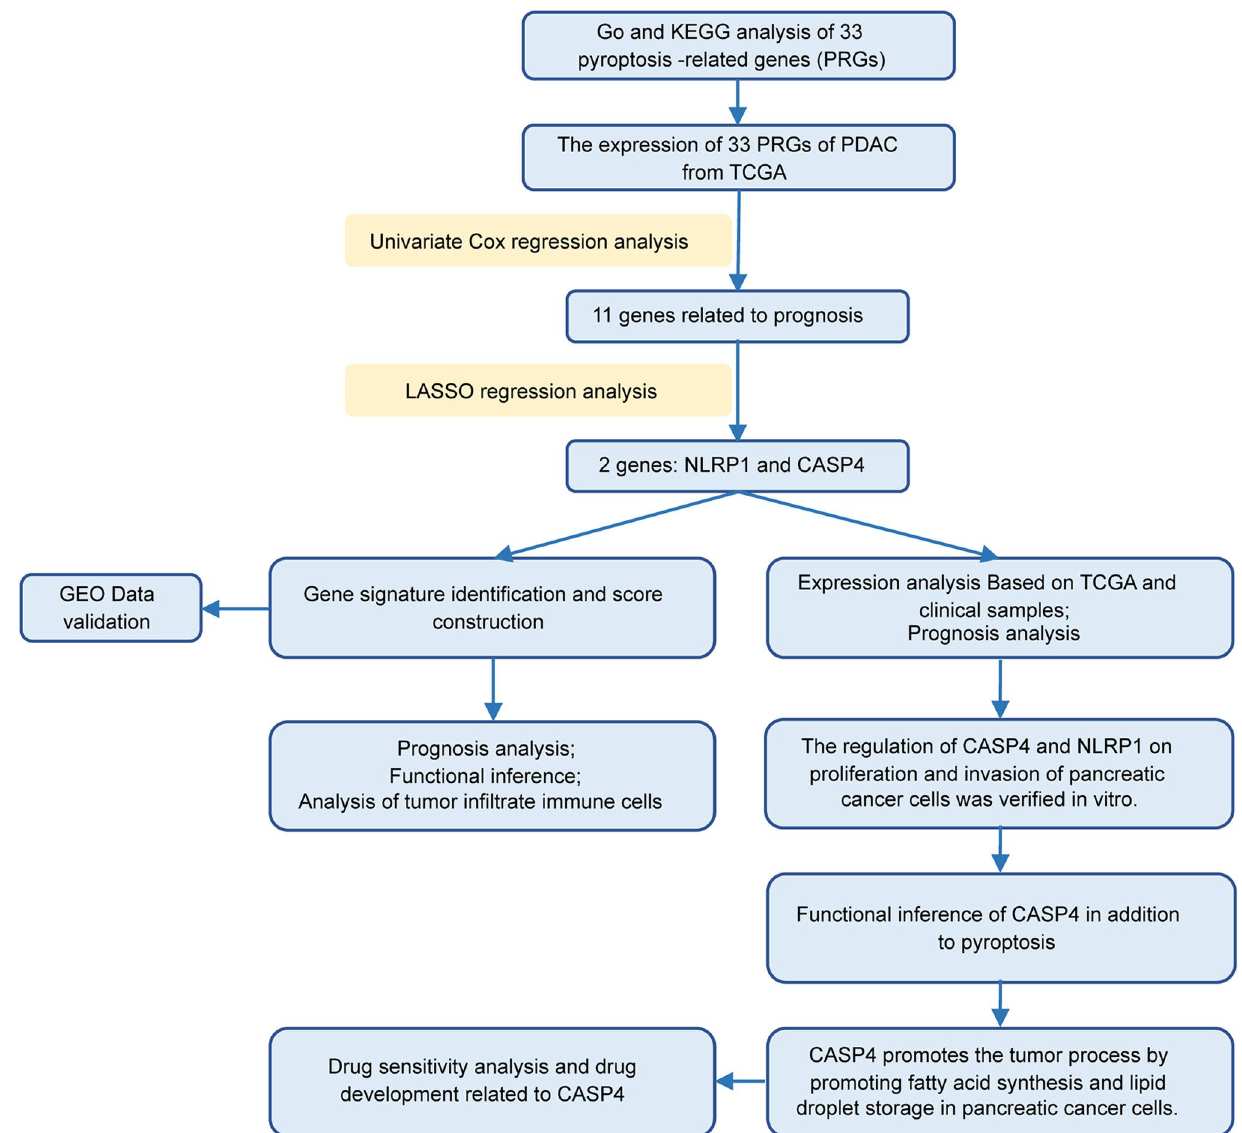
Fig. 1 The flow chart of the present